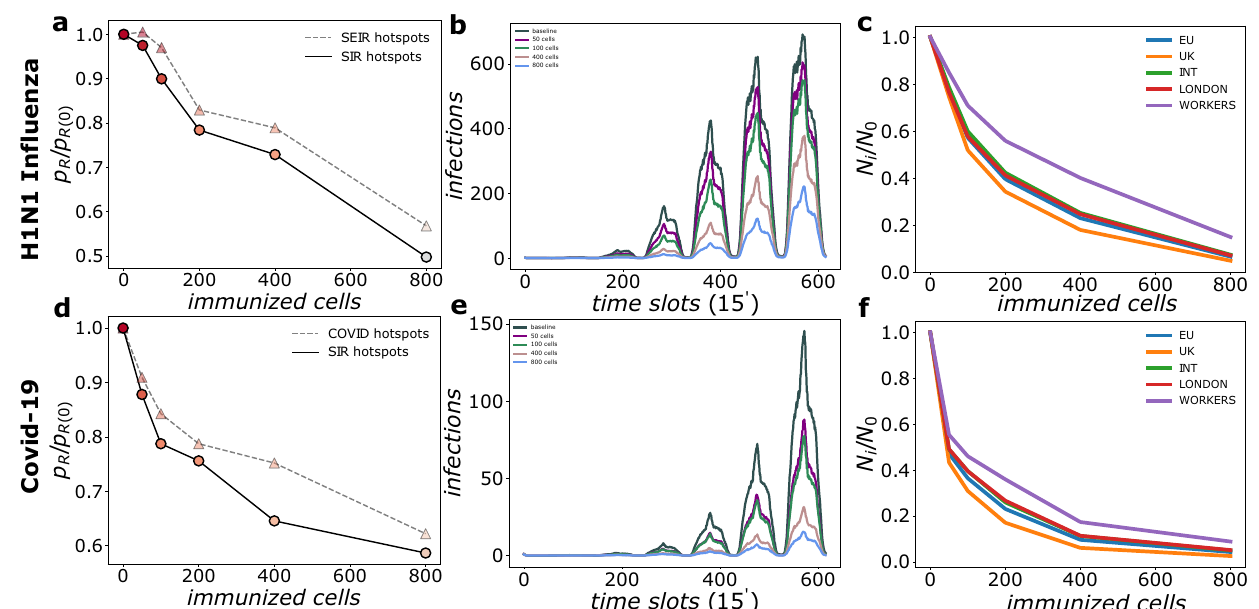
Fig.4 |Spatialimmunizationappliedtothespreadingofdiseasesdescribedby SEIR models. Panels a , b and c refer to results of simulations for H1N1 In fl uenza; And panels d , e and f to those for COVID-19. In terms of columns, panels a and d show the number of realizations with secondary contagions p R normalized by p R (0)(withoutspatialimmunization)asfunctionofthenumberofimmunizedcells. The cells to immunize are selected following the contagion ranking according to the i) SIR model (circles joined by solid black lines) and ii) corresponding SEIR